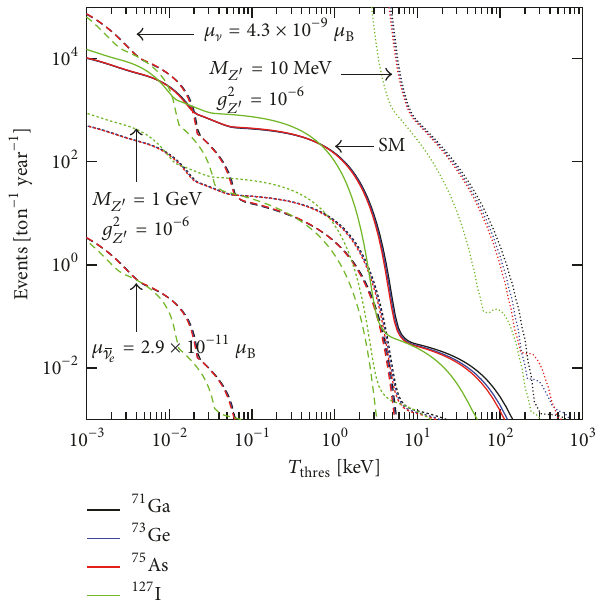
Figure 11: The neutrino-floor for various interaction channels. Solid, dashed, and dotted lines correspond to SM, EM, and 𝑍 耠 contributions, respectively.